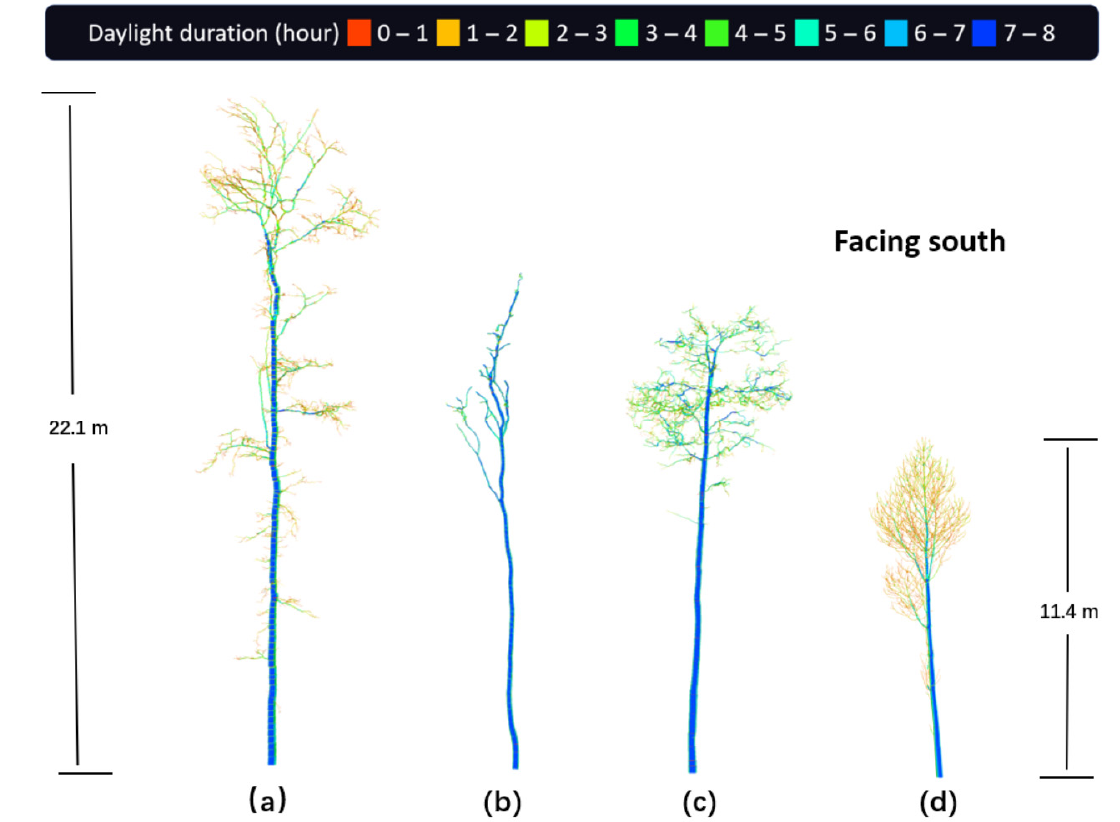
Figure 8. VMW implementation of light condition measurement on four tree species: ( a ) sessile oak (Quercus petraea) ; ( b ) gemu tree (Erythrophleum fordii) ; ( c ) Masson’s pine (Pinus massoniana) ; ( d ) cherry tree ( Prunus avium L.).